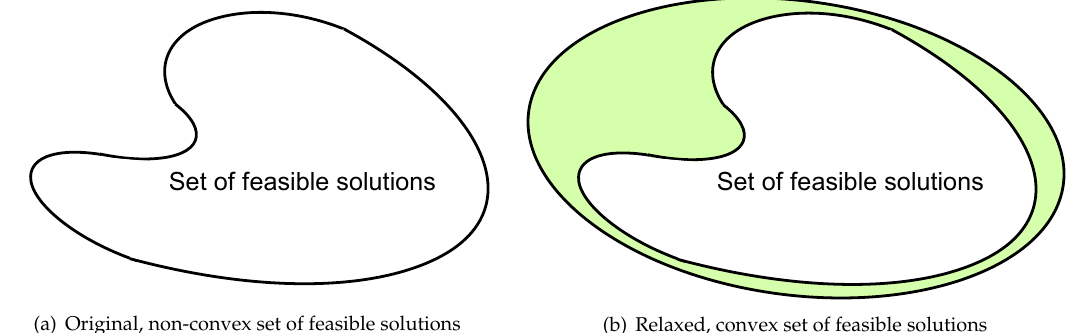
Figure 7. Illustration of the process of convex